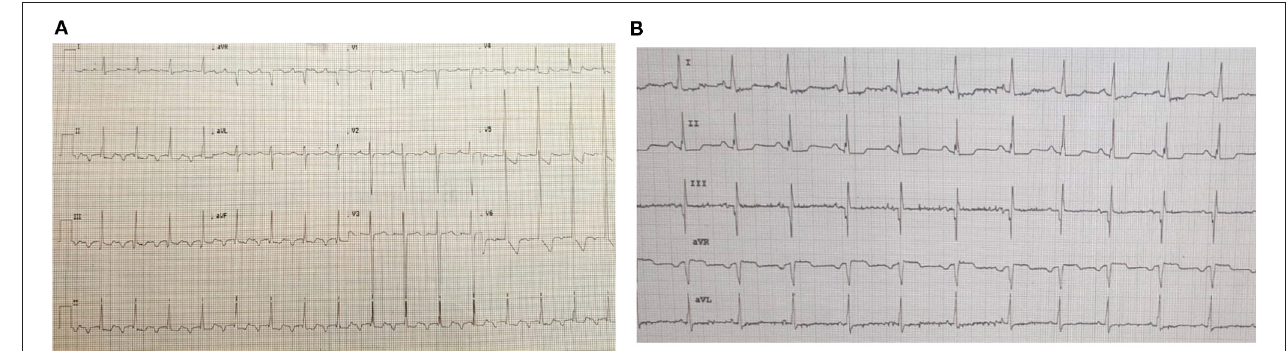
FIGURE 5 | ECGs of patient #3 pre- and post-ivabradine. (A) ECG showing incessant atrial tachycardia. (B) ECG showing sinus rhythm few hours after ivabradine initiation (ECG speed: 25 mm/s, and sensitivity: 10 mm/mv). This initial response to ivabradine was not maintained. As a result, the patient was switched to amiodarone.